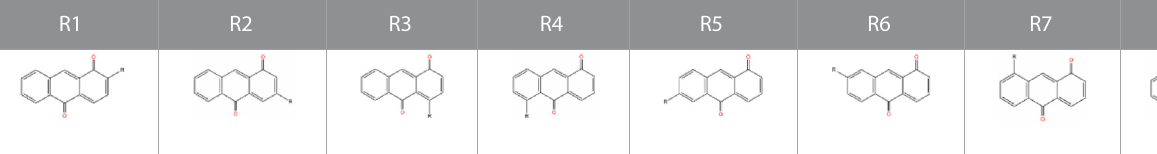
TABLE 2 The positions of substituent for a few representative quinone molecules. R1 R2 R3